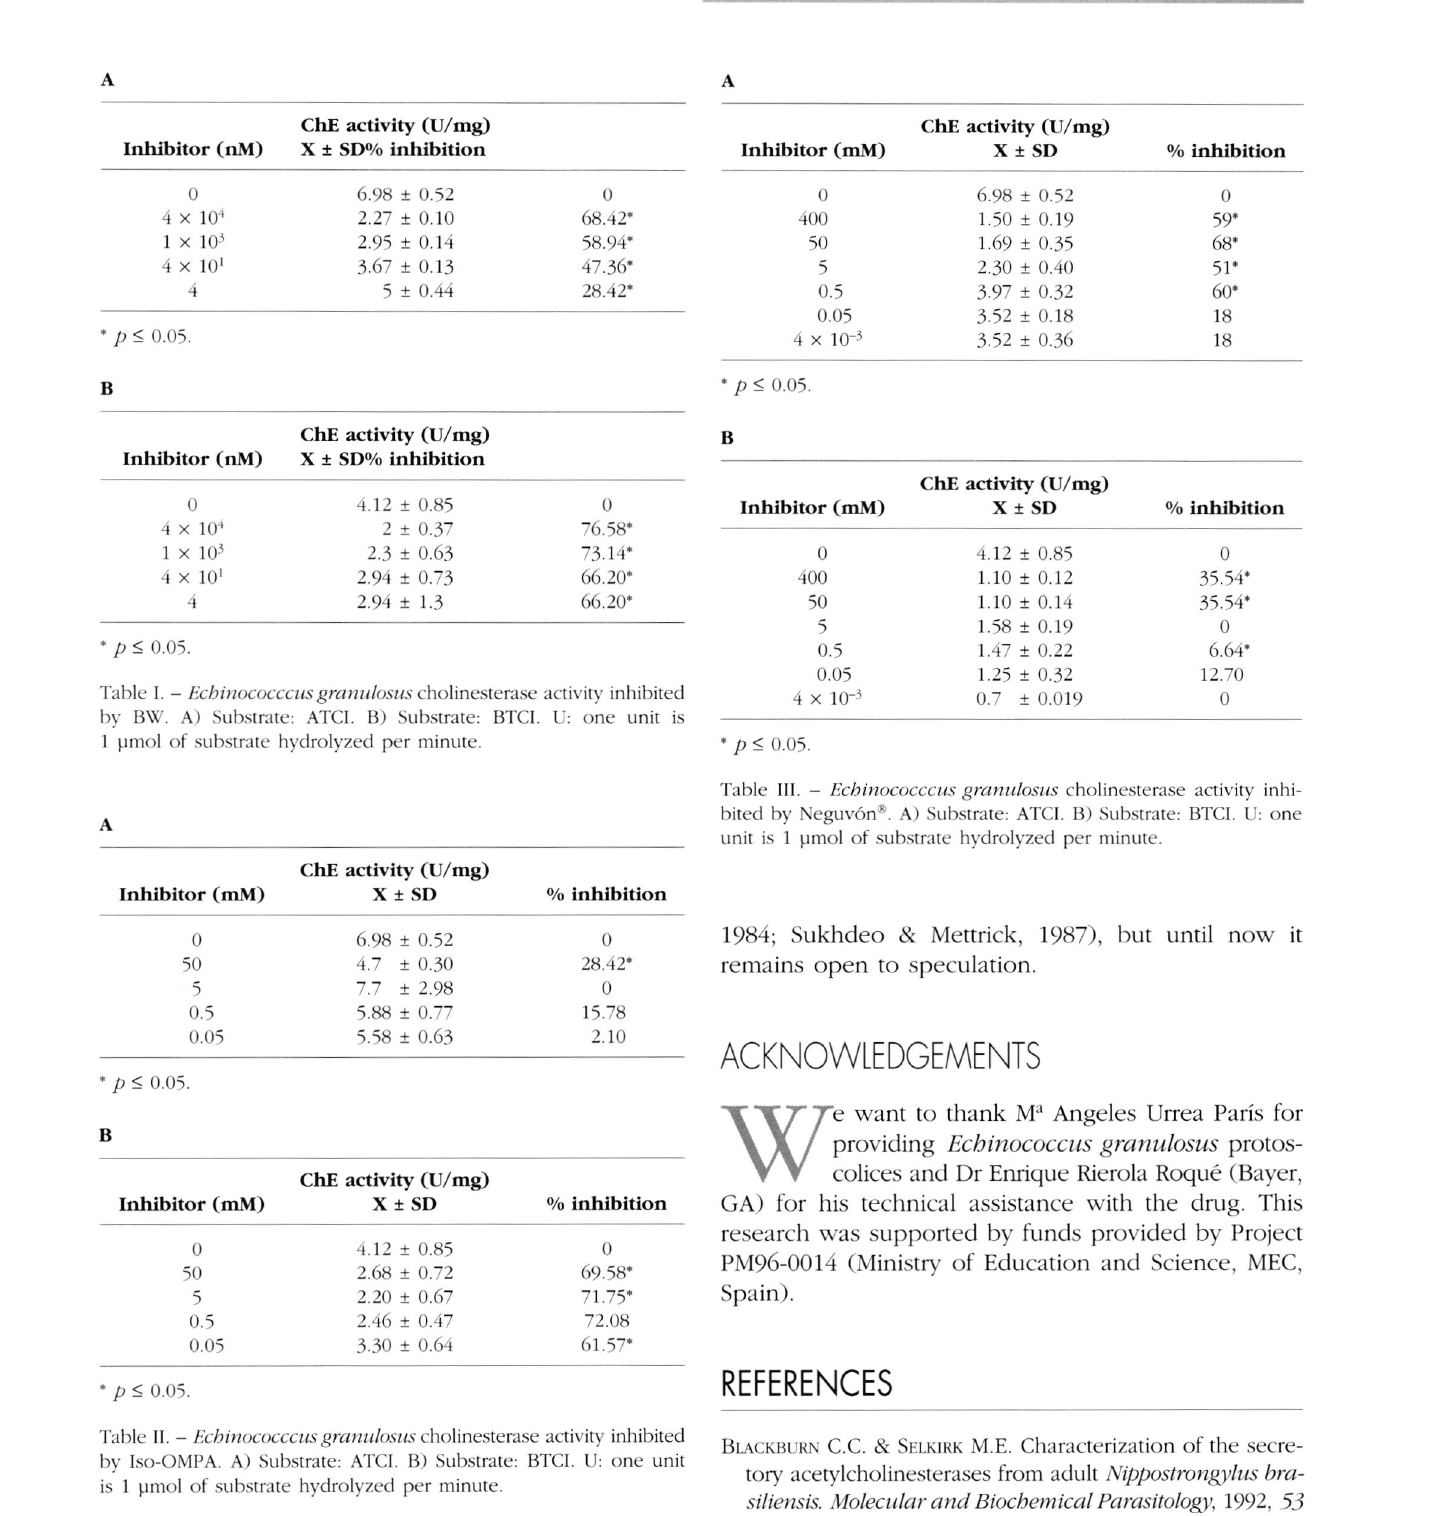
Table II. - Echinococccus granulosus cholinesterase activity inhibited by Iso-OMPA. A) Substrate: ATCI. B) Substrate: BTCI. U: one unit is 1 umol of substrate hydrolyzed per minute.